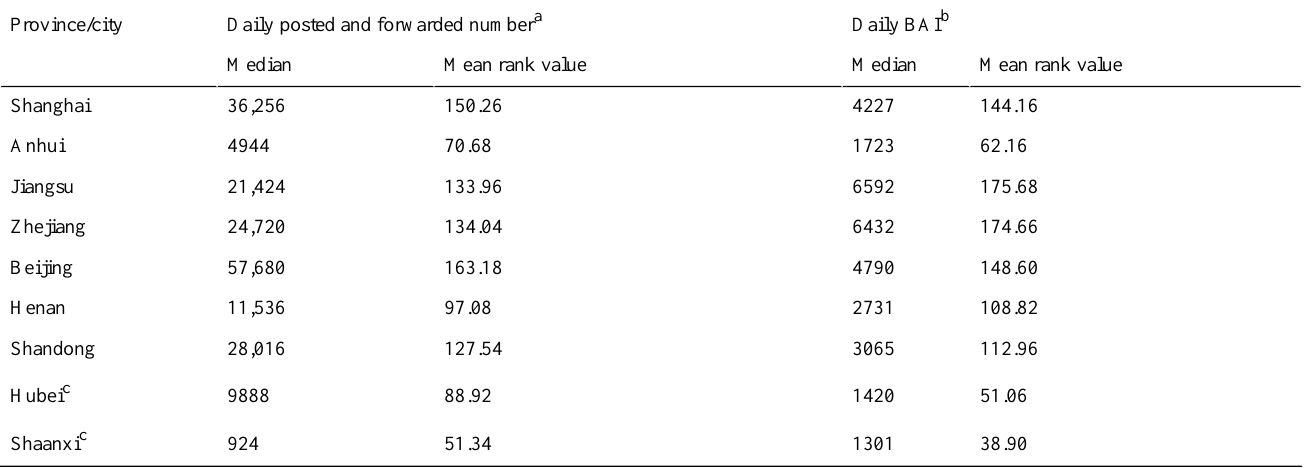
Table 1. The observed median daily posted and forwarded number and Baidu Attention Index (BAI) for H7N9 by province/city on Sina microblog and Baidu website from March 31 to April 24, 2013.